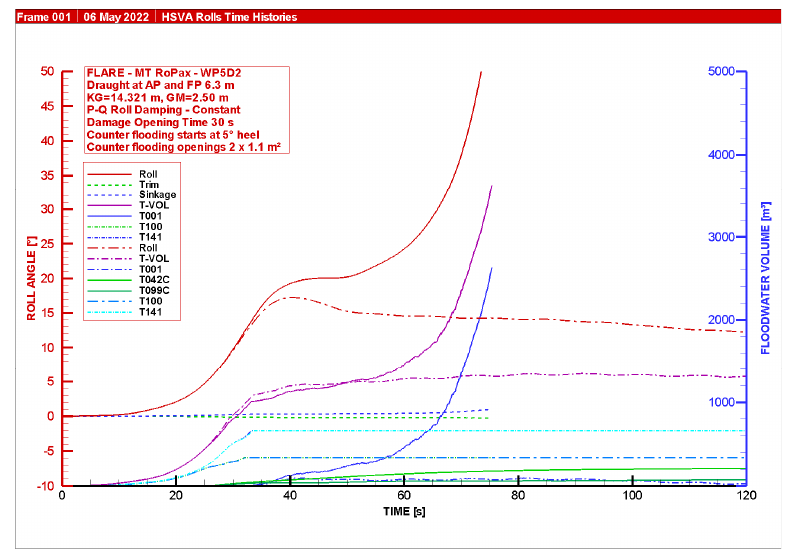
Figure 7. Counter flooding with damage opening time 30 s: The roll angle (red) and water volumes on trailer deck and in damaged compartments (bluish) and in those for counter flooding (green) are shown.